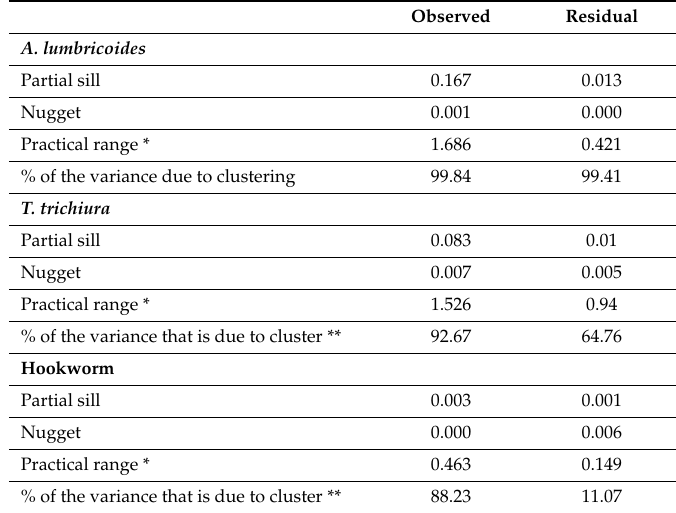
Table 2. Summary parameters of soil-transmitted helminth spatial semivariograms.